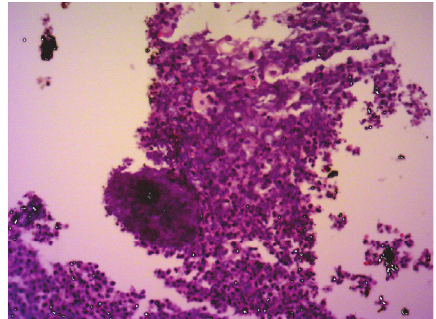
Figure 2: Sulfur granules from peritoneal aspiration, 40x.